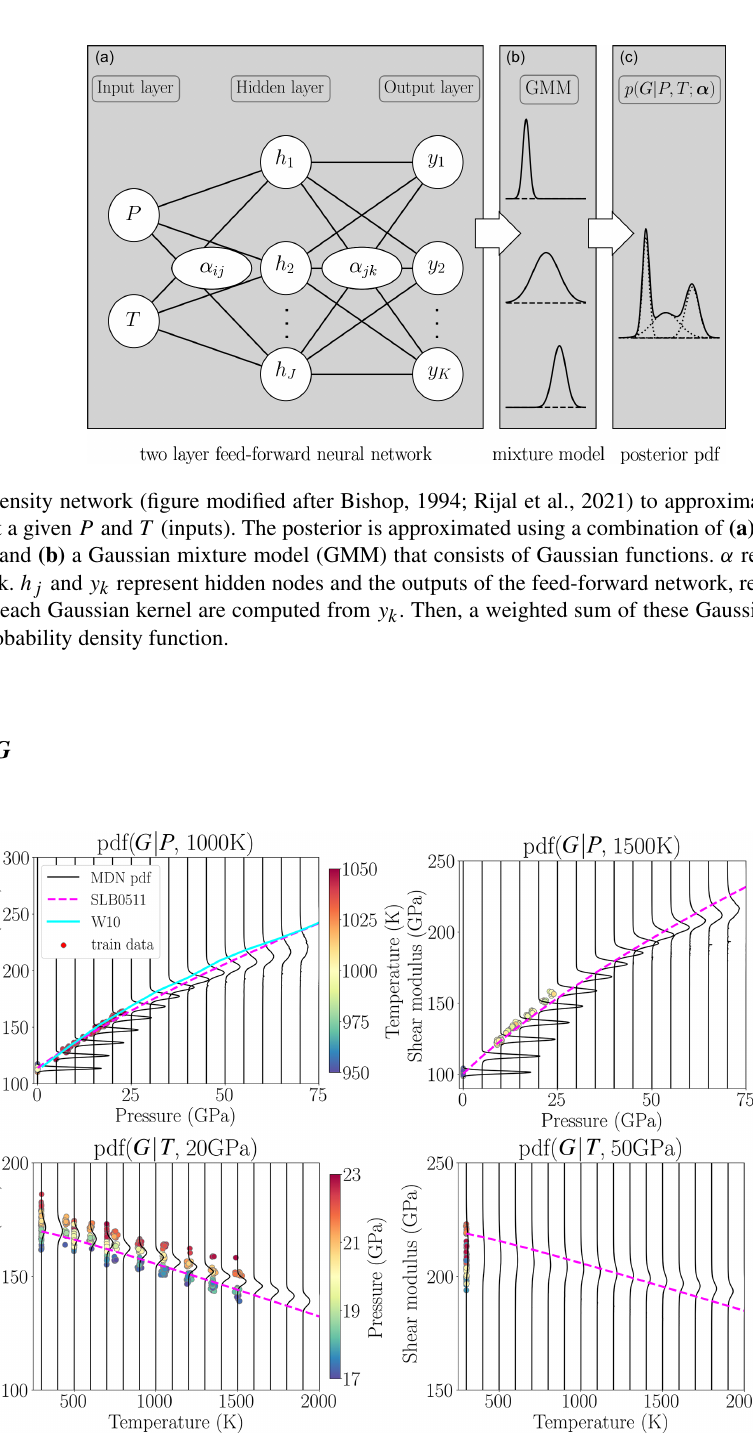
Figure D1. P – T – G relationship of MgO predicted by neural networks along 1000 and 1500K isotherms and 20 and 50GPa isobars. Previously published studies (Stixrude and Lithgow-Bertelloni, 2005, 2011; Wentzcovitch et al., 2010b) are also shown for comparison. Circles are the data that belong to temperature and pressure ranges shown by colour bars in each